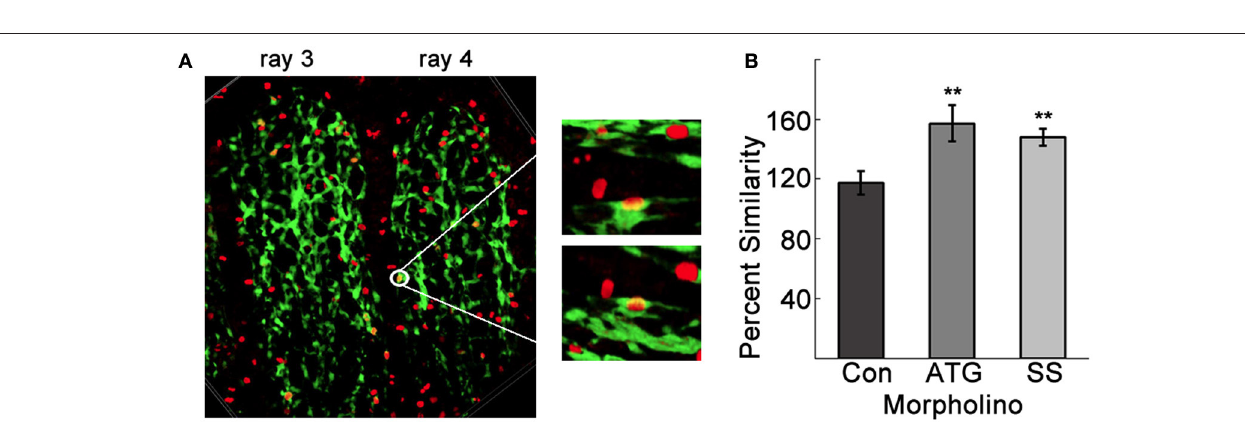
FIGURE 5 | Tmem184a knockdown results in increased endothelial cell proliferation. (A) Example confocal image projecting the third and fourth 4 dpa fin rays. The white circle highlights a point where fluorescence from GFP (green, ECs) H3P (red, Cy3 secondary antibody) overlap and look yellow. Zooming in on this point and rotating in a few different directions confirms nuclear H3P in an EC. (B) Quantitation of H3P/Fli1 ECs in the third and fourth fin rays of 4 dpa standard control, ATG, and SS MO-injected fins compared to third and fourth fin rays of the uninjected side. Graphs are shown as mean percent similarity ± S.E.M. ** p < 0.01 compared to control. Data are representative of more than three independent experiments with at least four fish per experimental